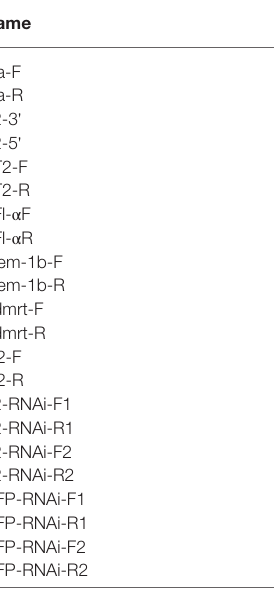
TABLE 1 | Primers for the present